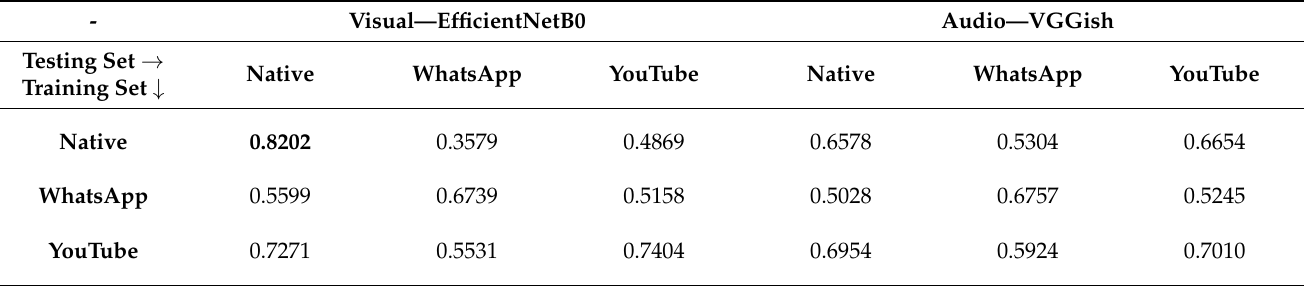
Table 1. Classification accuracy of mono-modal methods as a function of training/testing sets. In bold is the highest achieved classification